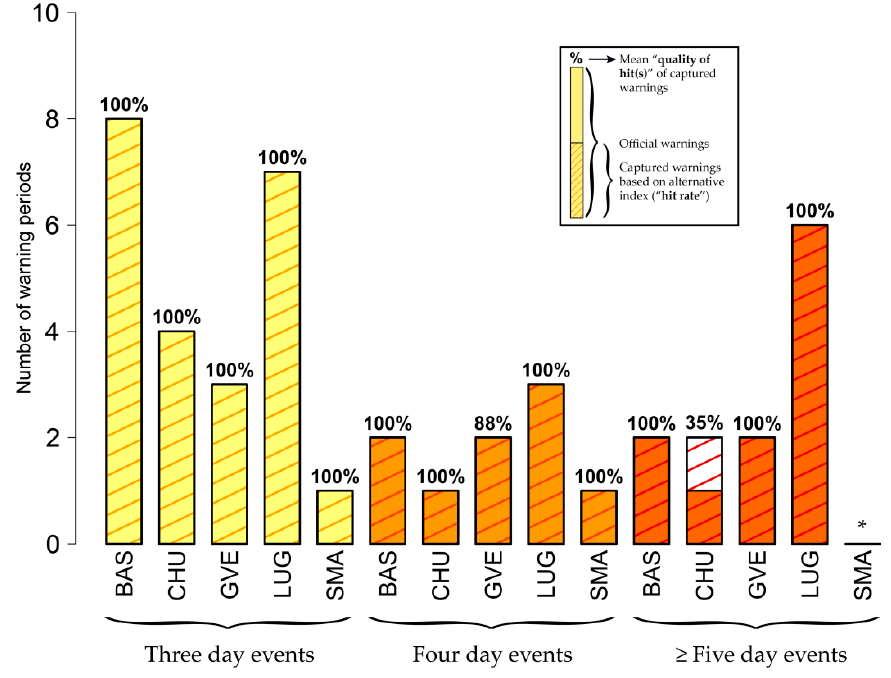
Figure 11. As Figure 10 but for swbgt .